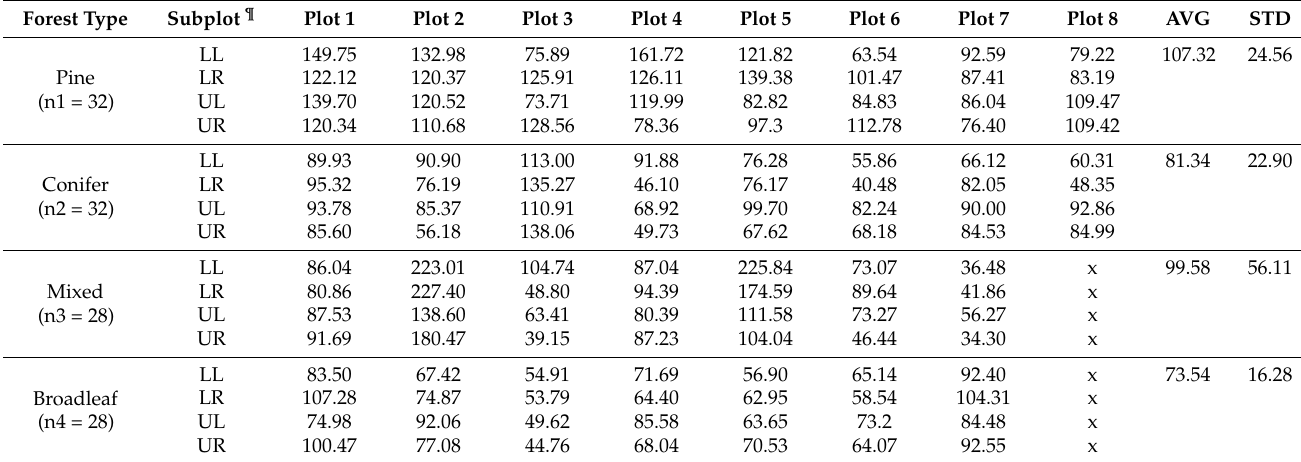
Table 2. The aggregated amount of fine surface fuel loads (fSFL) in level-2